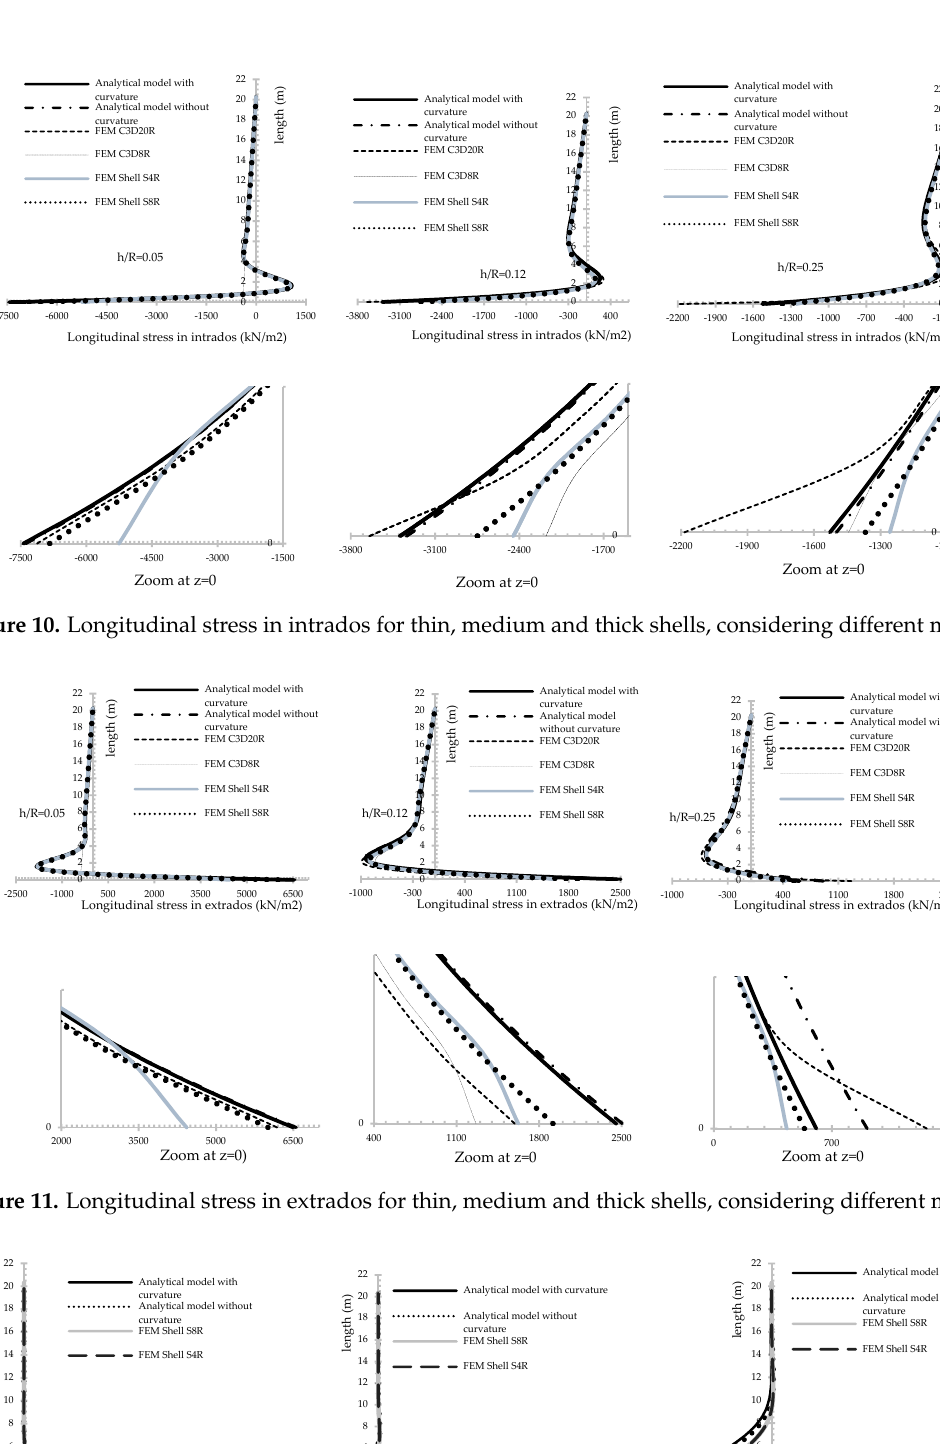
Figure 9. Circumferential stress in intrados for thin, medium and thick shells, considering different models.